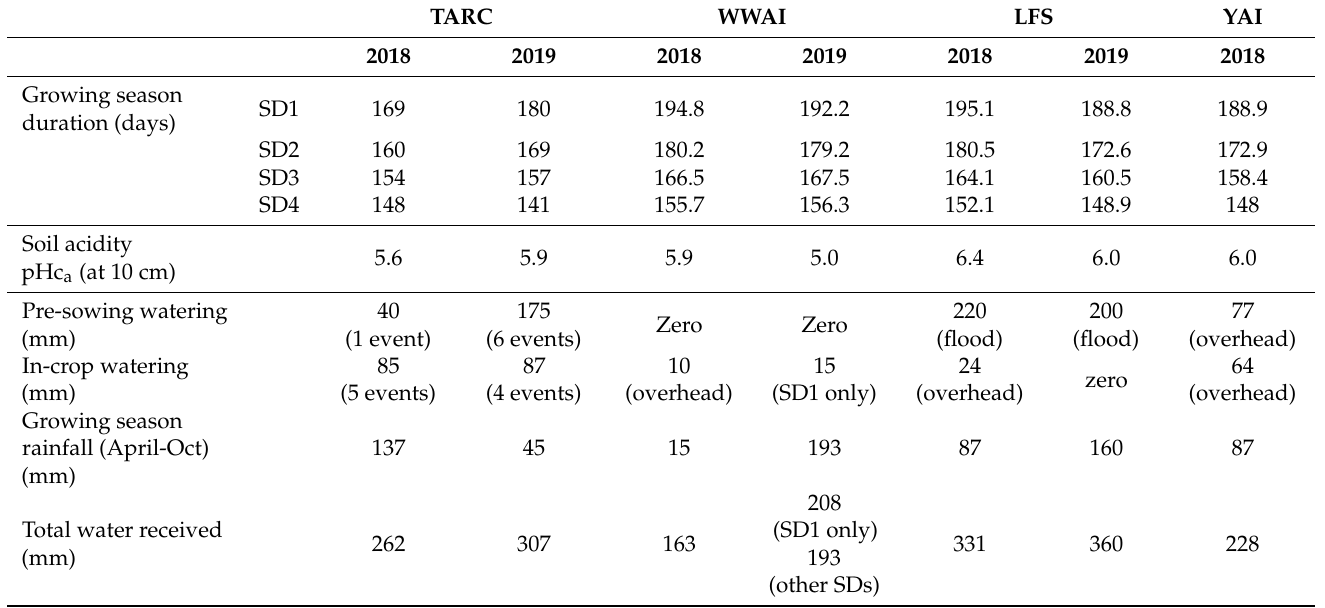
Table 2. Growing season duration across the sowing dates (SD), and water received during 2018 and 2019 at the experimental sites. TARC = Trangie Agricultural Research Centre; WWAI = Wagga Wagga Agricultural Institute; LFS = Leeton Field station; YAI = Yanco Agricultural Institute.